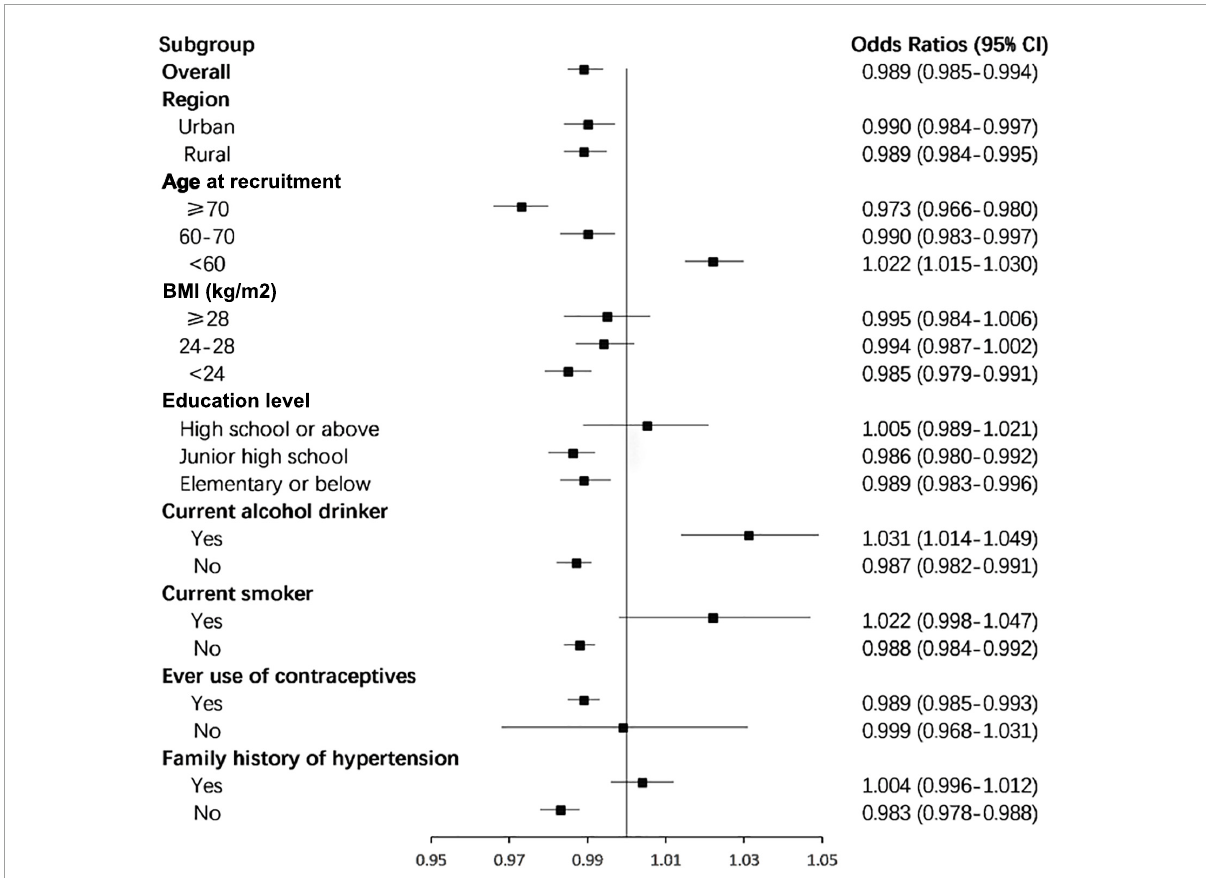
FIGURE3 Subgroup analyses of the associations between total reproductive years and risk of hypertension according to possible influencing factors. Analyses were adjusted for age at recruitment, body mass index, waist circumference, region, ethnicity, education level, smoking, alcohol drinking, family history of hypertension, stroke, myocardial infarction, pregnant, contraceptive use status, and breastfeeding